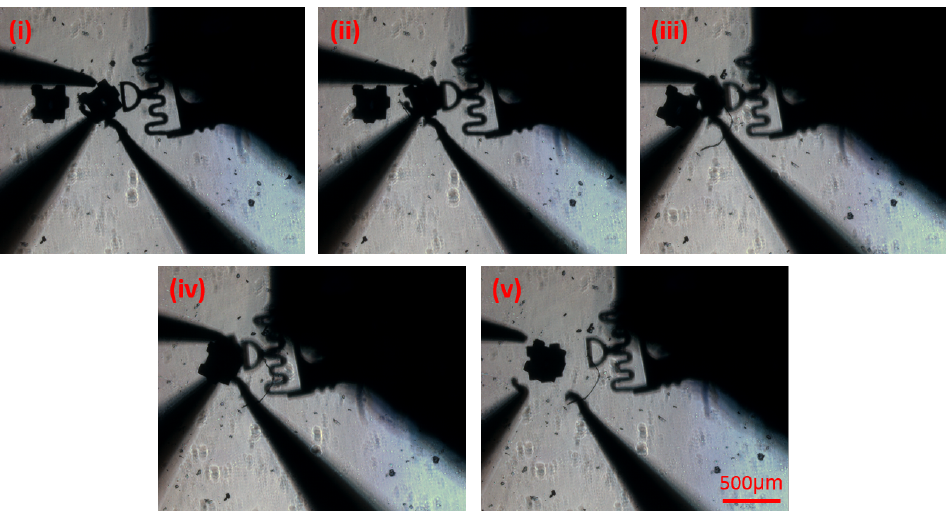
Figure 8. Summary of the 3D assembly (stacking) using the force-assisted cage primitive. Here, ( i ) represents the initial position, ( ii ), squeeze cage, ( iii ) and ( iv ) lift and move part, ( v ) drop and open